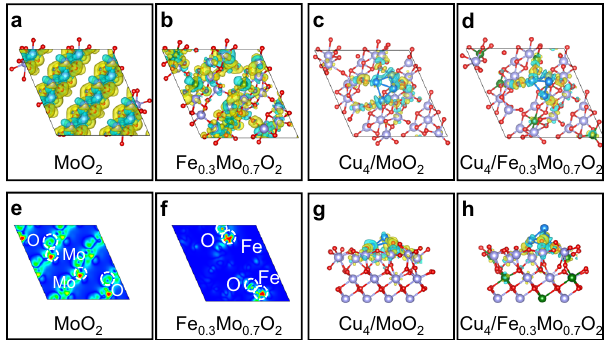
Fig. 4 Calculated electronic properties of Cu 4 /Fe 0.3 Mo 0.7 O 2 @C. Top view of the charge densities of a MoO 2 and b Fe 0.3 Mo 0.7 O 2 . Top view ( c , d ), and side view ( g , h ) of the calculated charge transfer difference between subnanometric Cu 4 cluster and MoO 2 ( c and g ) or Fe 0.3 Mo 0.7 O 2 ( d and h ). 2D charge density distributions of MoO 2 ( e ) and Fe 0.3 Mo 0.7 O 2 ( f ). The isosurface value is set to be 0.005 e/Å 3 and the yellow and cyan areas refer to the charge accumulation and depletion, respectively. Cu (blue), Fe (green), Mo (purple), and O